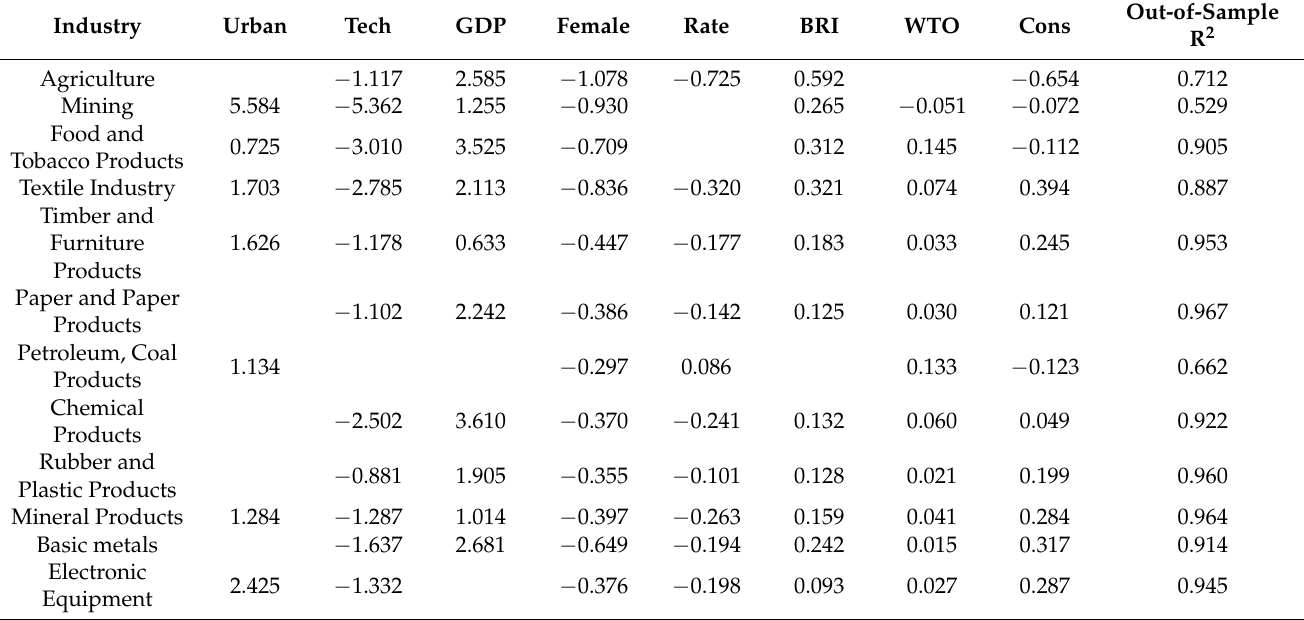
Table 6. The LASSO regression results by